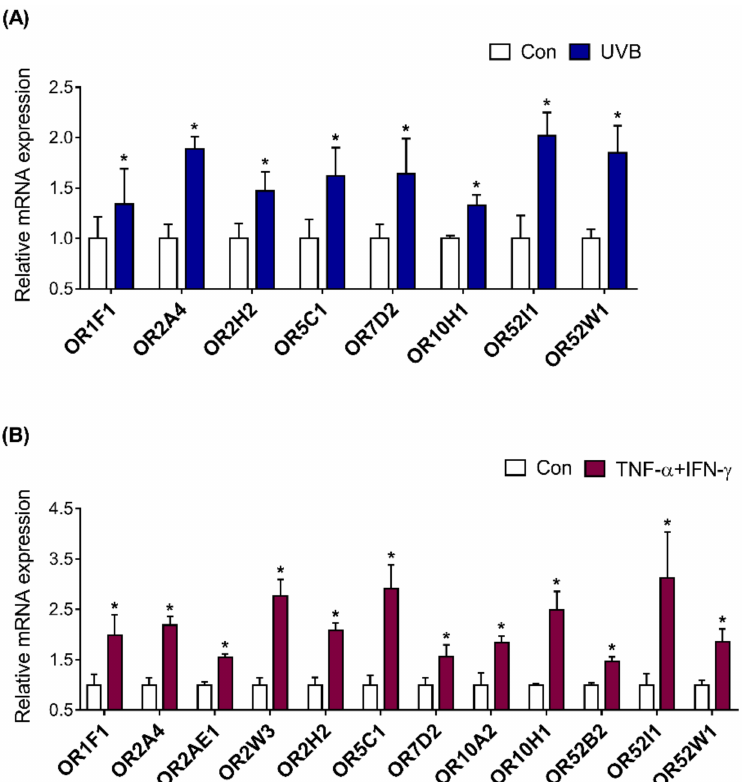
Figure 5. Investigation of olfactory receptor (OR) expression in UVB-irradiated and inflamed HaCaT cells. ( A ) The cells were treated with or without UVB irradiation (10 mJ/cm 2 ) and incubated for 48 h. Then, the relative mRNA expression of eight ORs ( OR1F1, OR2A4, OR2H2, OR5C1, OR7D2, OR10H1, OR52I1, and OR52W1 ) was determined. ( B ) HaCaT cells were stimulated with or without TNF- α /IFN- γ (10 ng/mL each) and harvested after 48 h. Thereafter, the relative mRNA expression of 12 ORs ( OR1F1, OR2A4, OR2AE1, OR2W3, OR2H2, OR5C1, OR7D2, OR10A2, OR10H1, OR52B2, OR52I1, and OR52W1 ) was evaluated. Results are shown as mean ± SEM of three experiments. * p < 0.05, between the